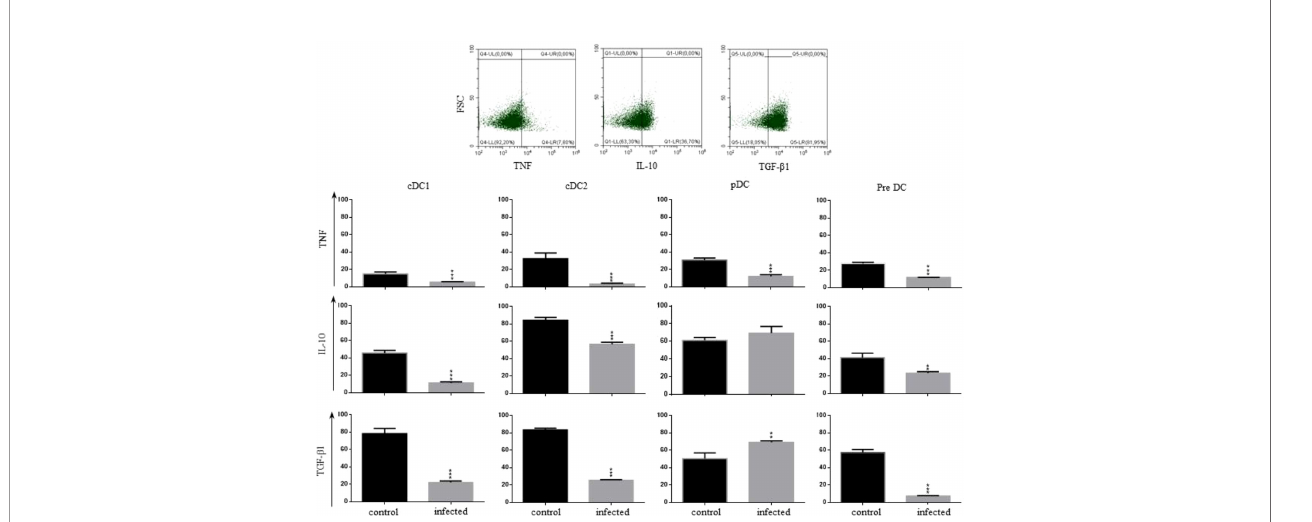
FIGURE 2 | Pro fi le of cytokines produced by hepatic dendritic cells: The de fi nition of TNF- a + , IL-10 + , or TGF- b 1 + cells was done as illustrated in the dot plots. The frequency of cDC1, cDC2, pDCs, and pre DC producing TNF- a , IL-10, or TGF- b 1 was evaluated by fl ow cytometry in control and T. cruzi infected mice on dpi 15, with the complete gating strategy shown in Supplementary Figures 1 (control) and 2 (infected mice). Statistically signi fi cant differences are shown as ** p ≤ 0.05 and ***p ≤ 0.01 using the one-way ANOVA test followed by Tukey ’ s